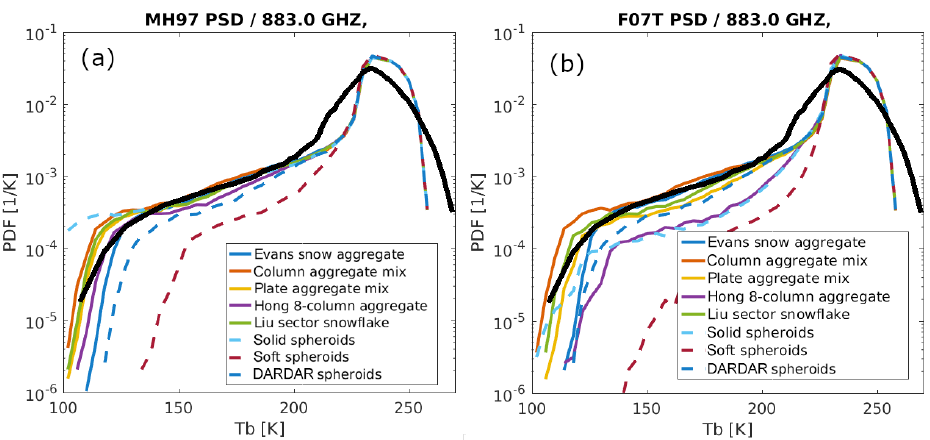
Figure 7. PDF comparison of the IceCube TB (bold black line) against various ARTS model simulations using 3 months of tropical CloudSat observations and different ice shape assumptions and two particle size distribution assumptions: (a) MH97 PSD and (b) F07 PSD. Only IceCube observations within a ± 15 ◦ viewing angle, at 15 ◦ S–15 ◦ N and during June–July–August 2017 are